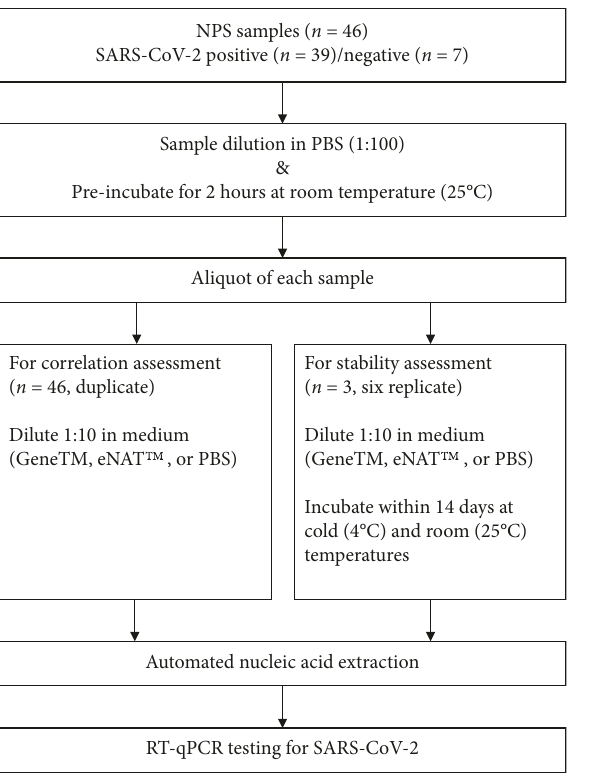
Figure 1: Assessment flowchart of the alternative transport media for SARS-CoV-2 testing. NPS, nasopharyngeal swab; PBS, phos- phate-buffered saline; GeneTM, Gene transport medium; RT- qPCR, quantitative reverse transcription polymerase chain